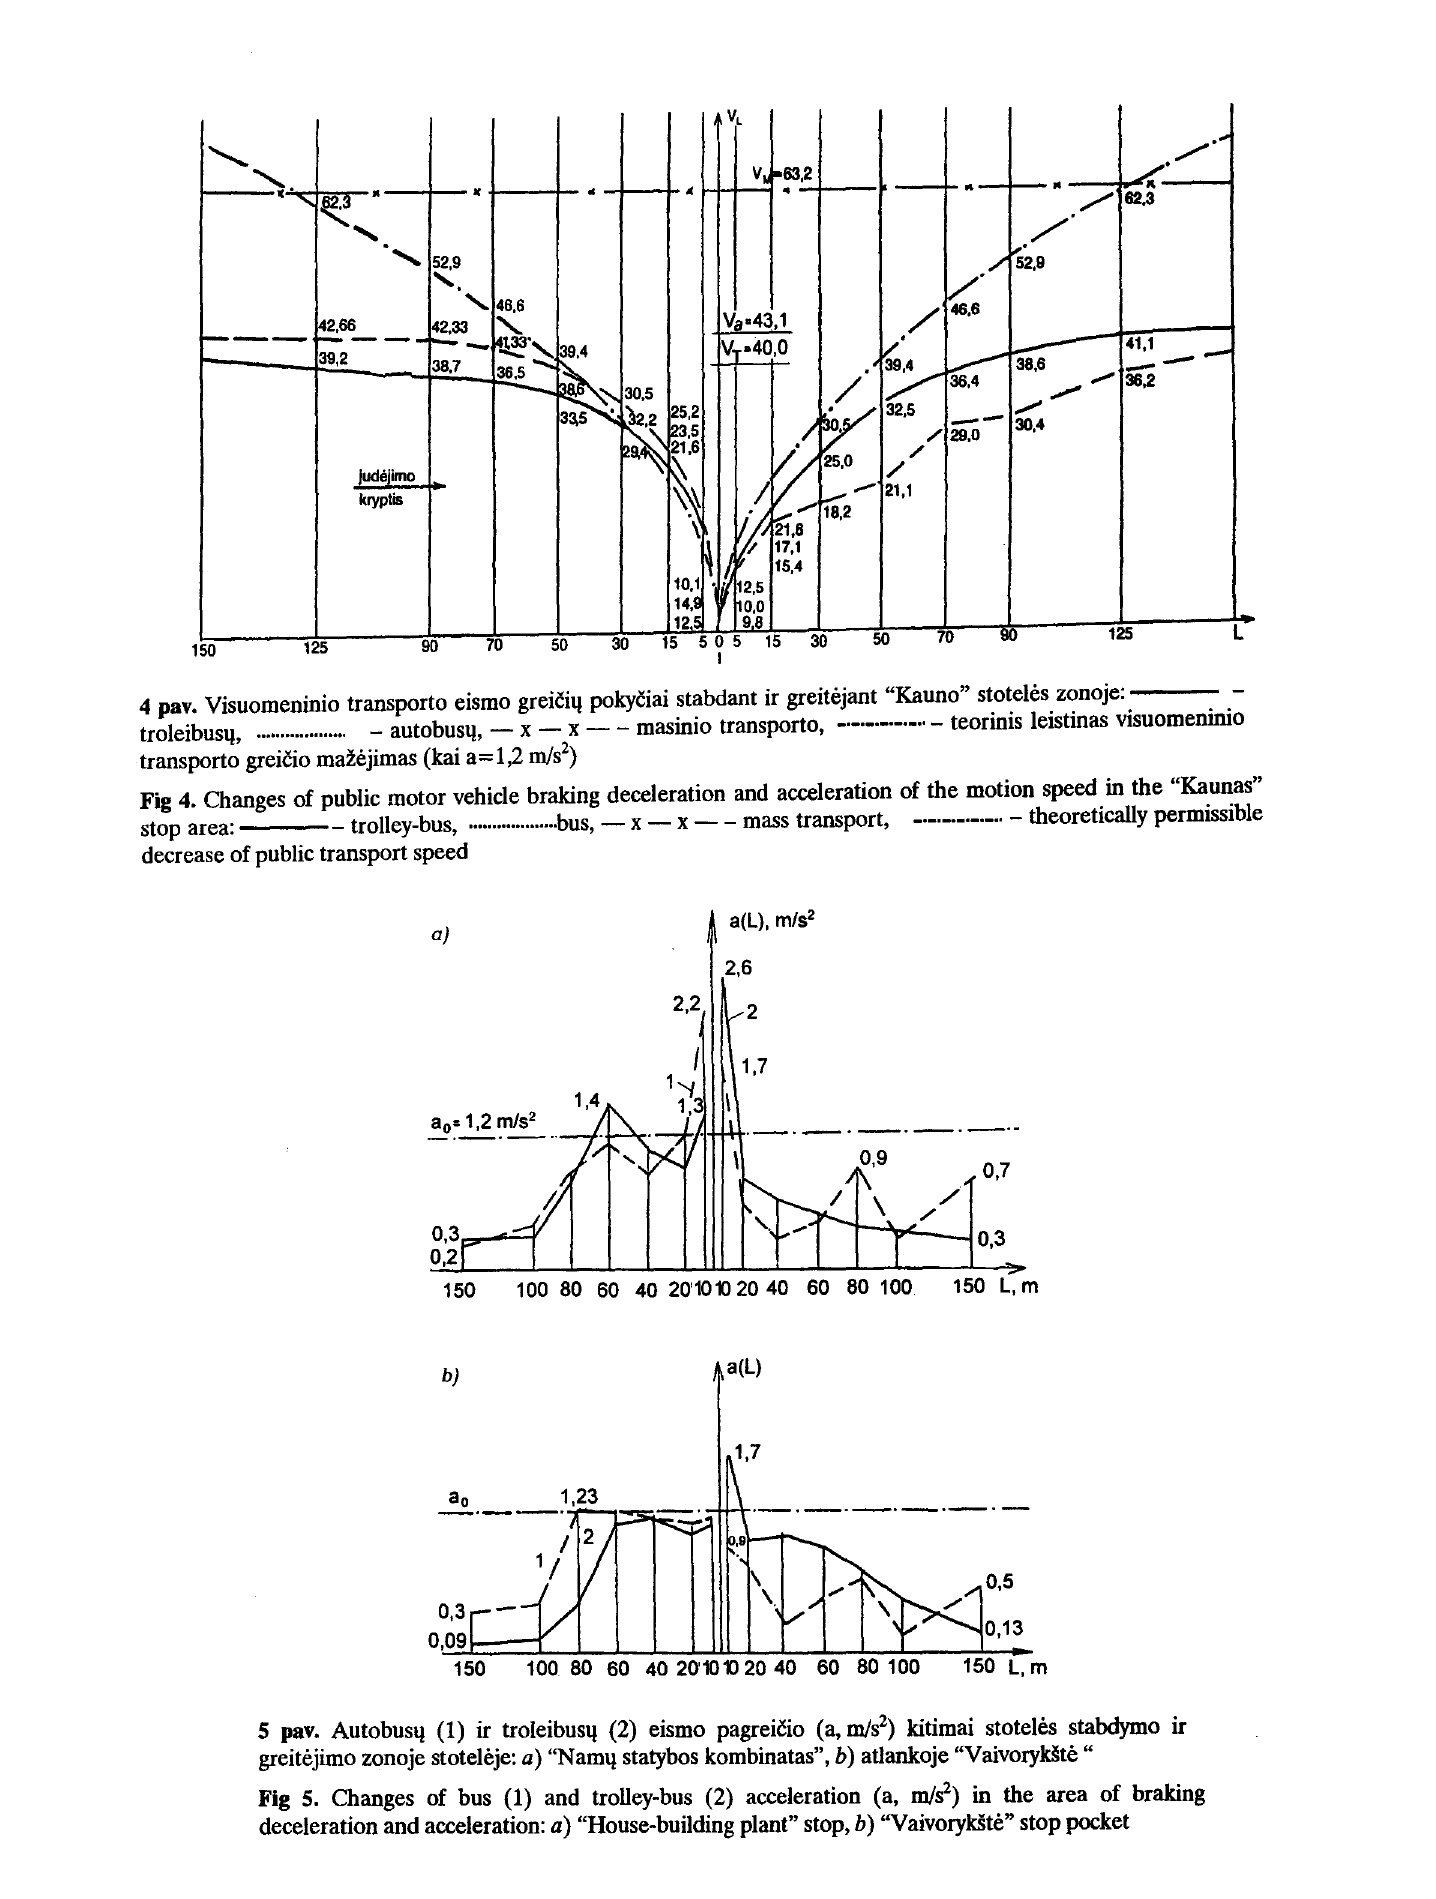
Fig 5. Changes of bus (1) and trolley-bus (2) acceleration (a, m/s 2 ) in the area of braking deceleration and acceleration: a) "House-building plant" stop, b) "VaivorykSte" stop